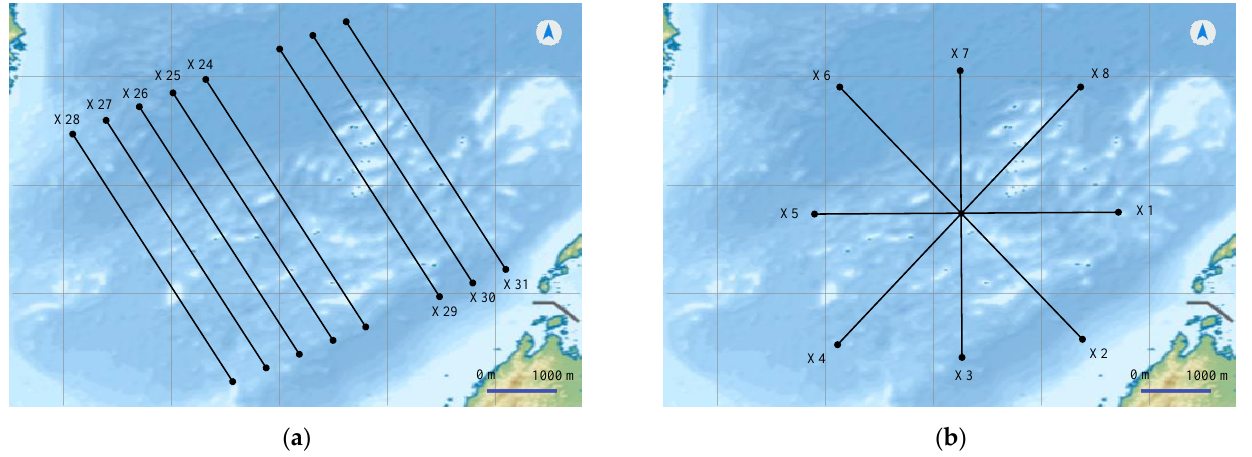
Figure 10. Components of the main line layout: ( a ) parallel survey lines; ( b ) star survey lines. First, we lay out eight parallel main survey lines and five inspection lines in the sim- ulated sea navigation system. As shown in Figure 11, the interval between the eight main lines is about 300 m, and the direction of the main lines is 180° . Then we assume that the minimum turning radius of the sea survey vessel is 100 m. Figure 12 is a schematic diagram of the original navigation system with an unreasonable navigation trajectory. The trajectory does not take the actual turning radius of the survey vessels into consideration. When the vessel reaches survey line Z2, it cannot adjust the vessel’s direction to make it drive along Z2. Obviously, the original navigation route cannot be applied to the actual navigation.